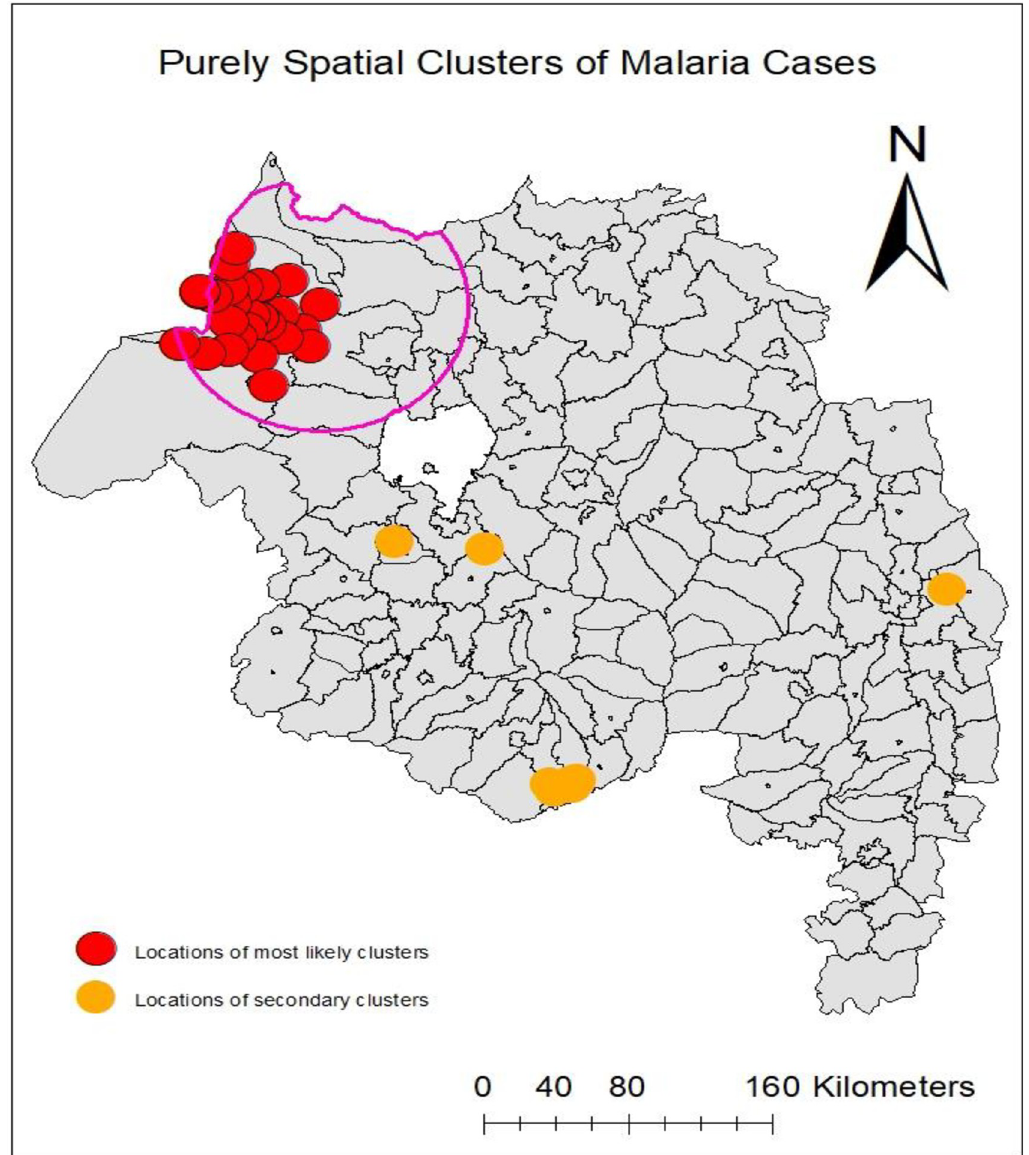
Fig 6. Purely spatial clusters of malaria cases were detected using SaTScan TM in the Amhara Regional State, Ethiopia between 2013 and 2018. Copyright: © 2022 Zeleke et al. The data on the map is derived from CSA, Ethiopia and APHI, Bahir Dar.